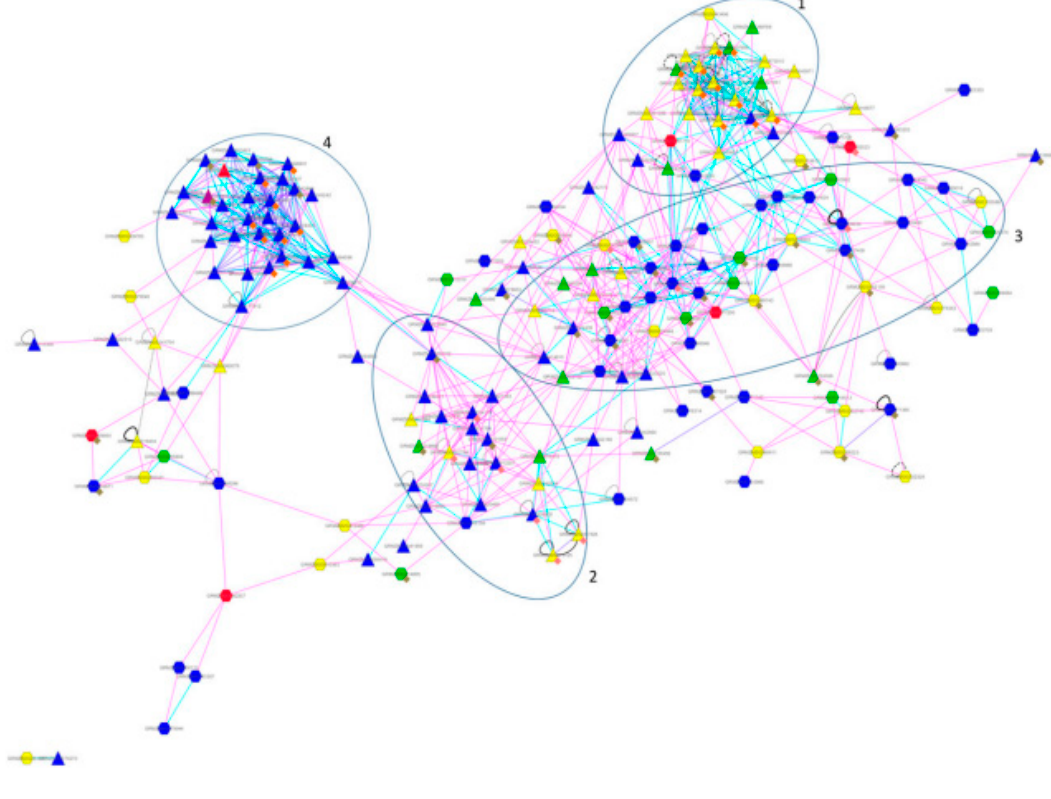
Figure 2. Four subnetworks achieved in the first case [58].